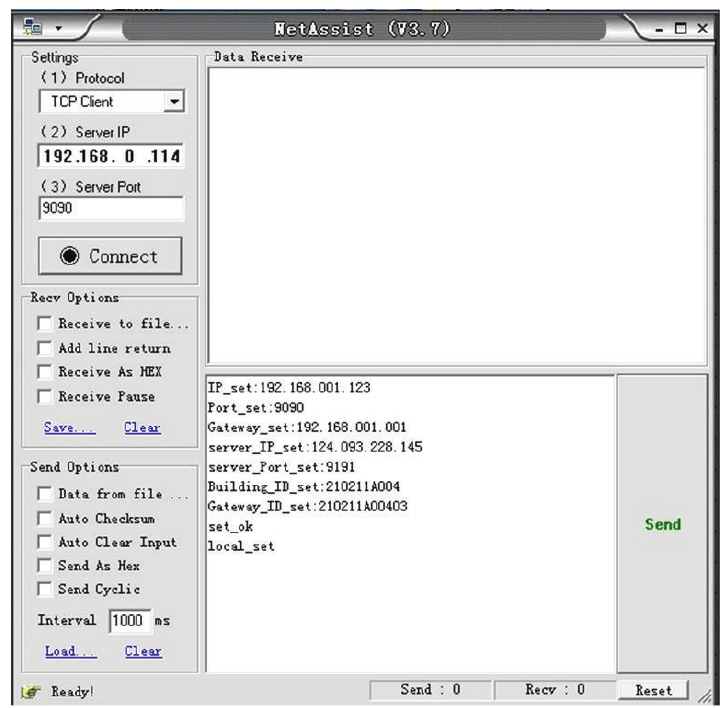
Figure 8: Configuration of data collector.